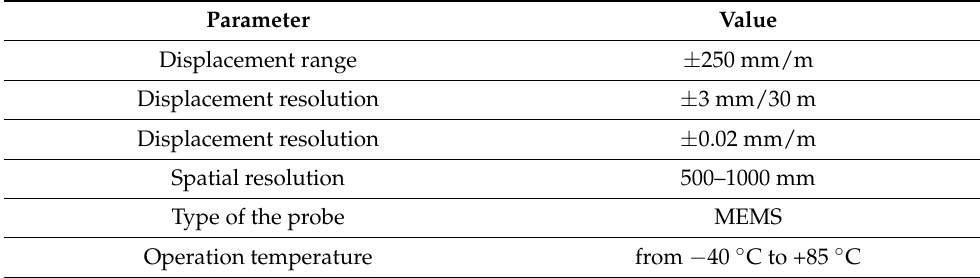
Table 4. Technical specifications of applied reference inclinometer system